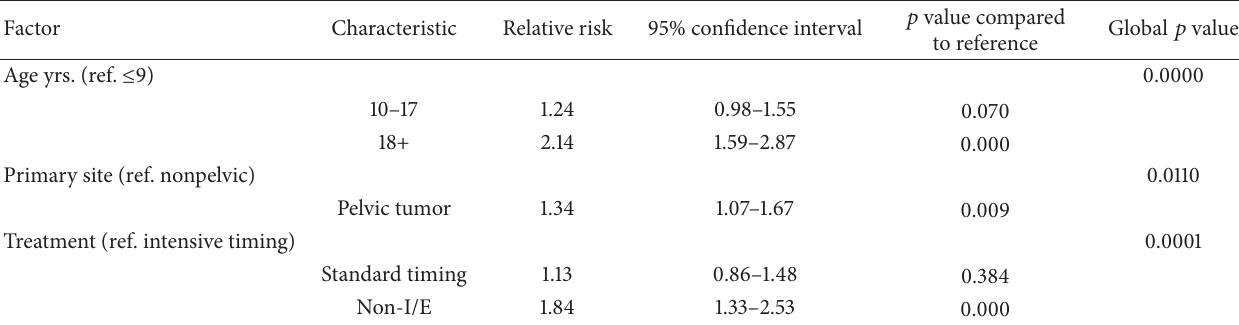
Table 4: Estimated risk coefficients for multivariate analysis excluding extraosseous patients ( 𝑁 = 1231).